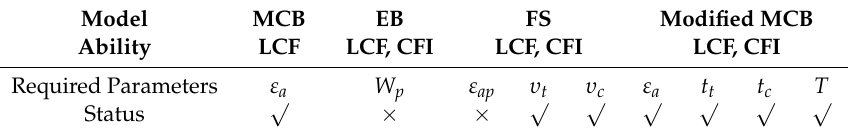
Figure 9. ( a ) Comparison between experimental life and predicted life using MMCB model, ( b ) the ratio of experimental life to predicted life versus different strain amplitudes.